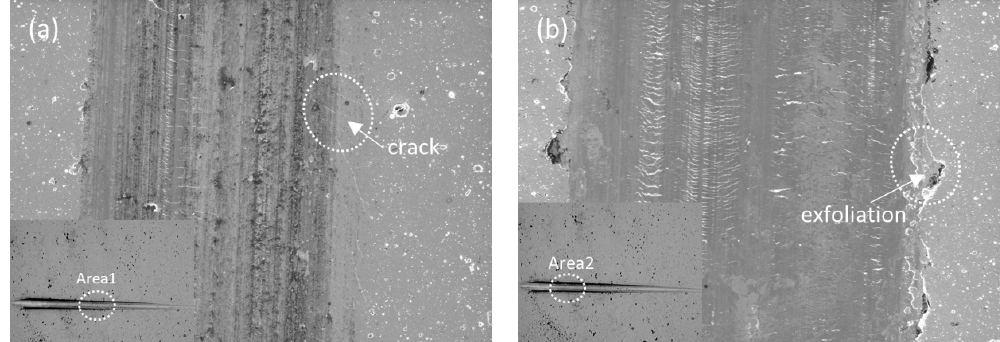
Figure 10. Acoustic signal curve of scratches.